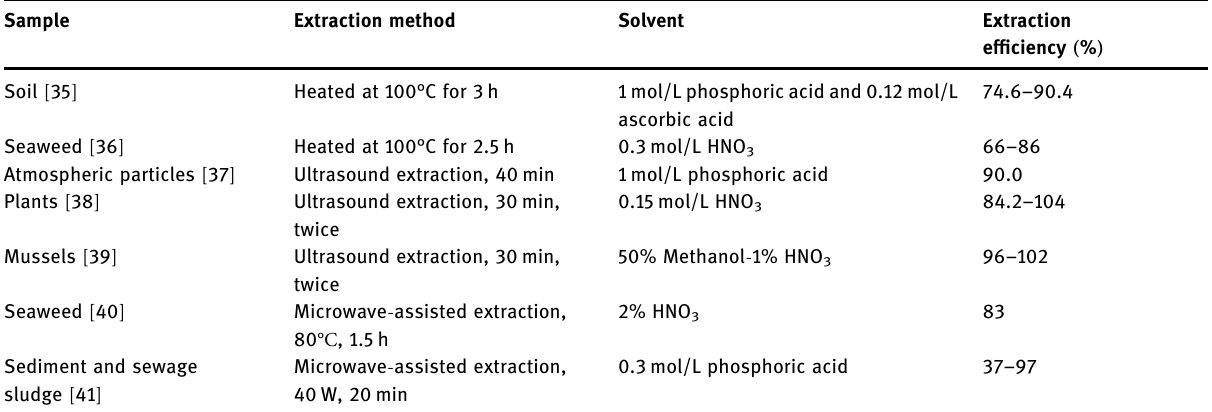
Table 4: Extraction method of As speciation